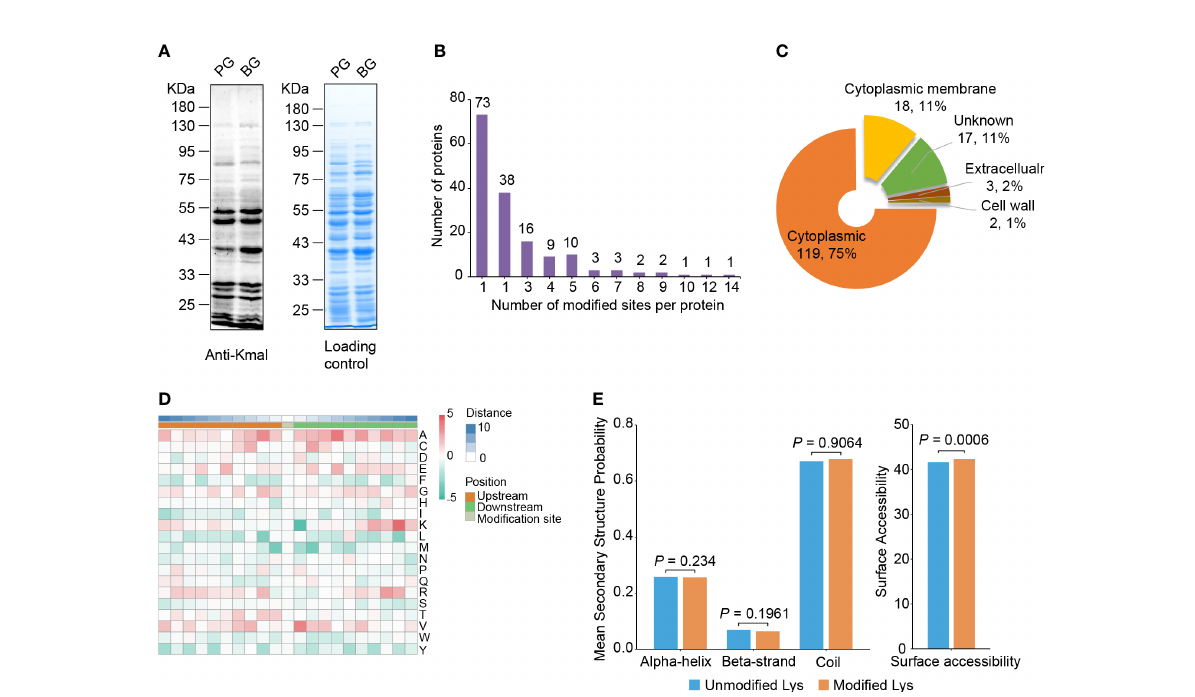
FIGURE 1 Lysine malonylome pro fi ling in S. mutans. (A) Immunoblot analysis of malonylated proteins with pan anti-Kmal antibody in S. mutans from planktonic growth (PG) and bio fi lm growth (BG). Coomassie brilliant blue R-250 staining of SDS-PAGE gel as the loading control. (B) The number of malonylated sites identi fi ed per protein in S. mutans . (C) Subcellular localization prediction of modi fi ed proteins. (D) Motif analysis of all identi fi ed Kmal proteins. Red indicates high frequency and green means low frequency. (E) Distribution of Kmal sites in different secondary structures (left panel) and their surface accessibility (right panel). The P values were calculated with the Wilcoxon